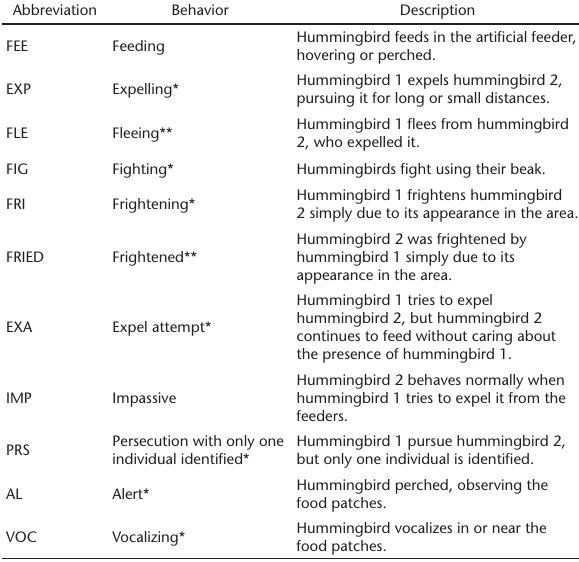
Table 1. Ethogram for the hummingbirds recorded at the Itacolomi State Park, Ouro Preto, Minas Gerais,